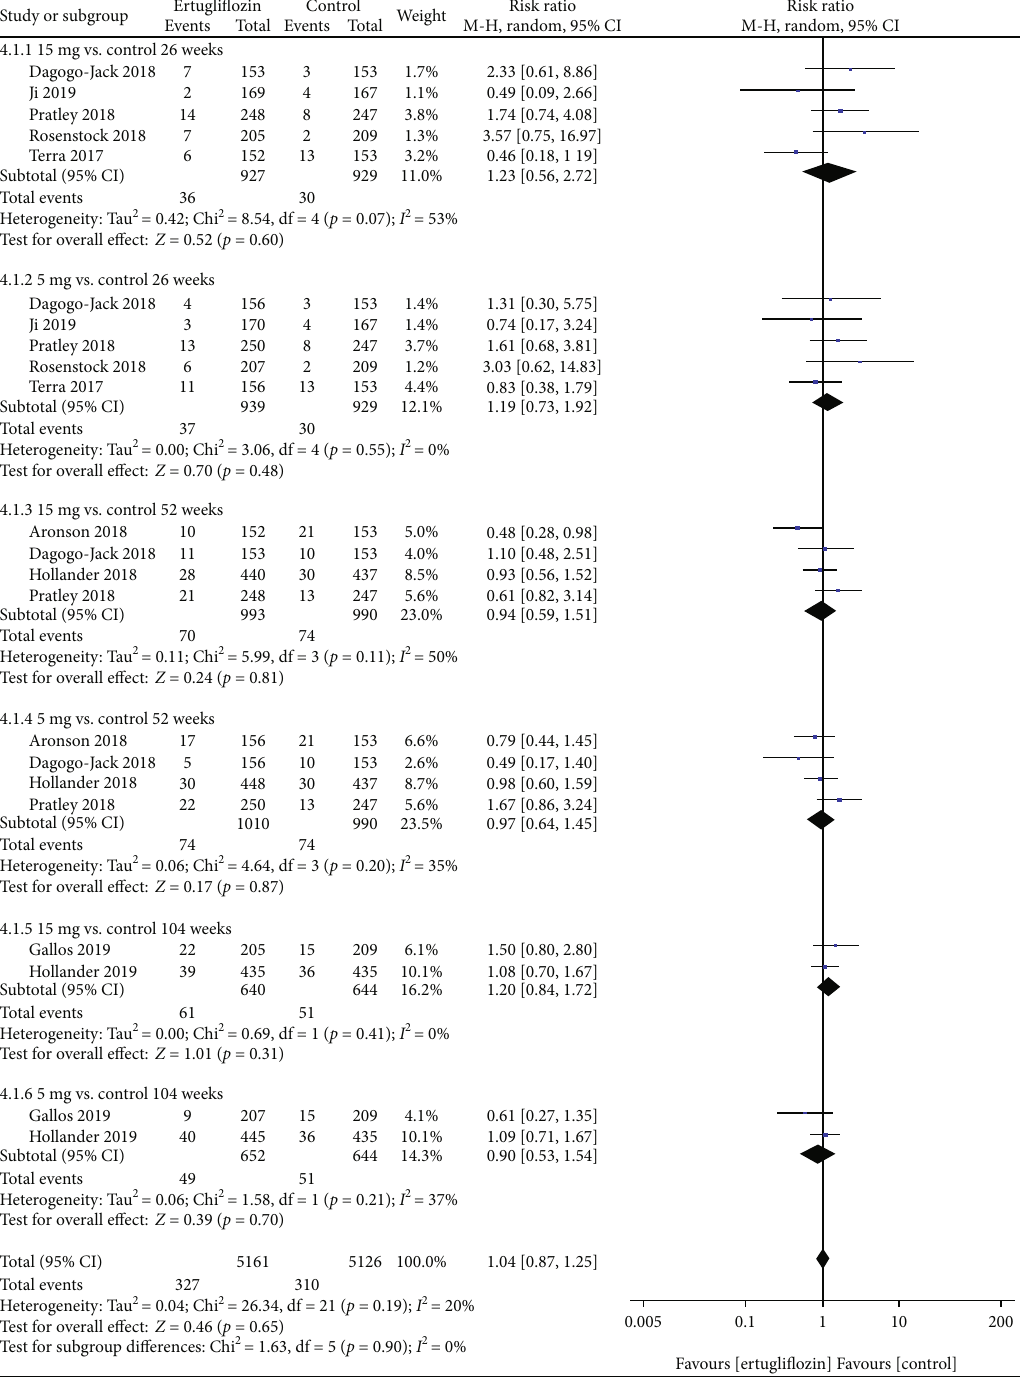
Figure 5: Forest plot of the risk of UTIs in the 15mg and 5 mg dose groups compared with that in the control group at 26, 52, and 104 weeks. CI: con fi dence interval; M-H: